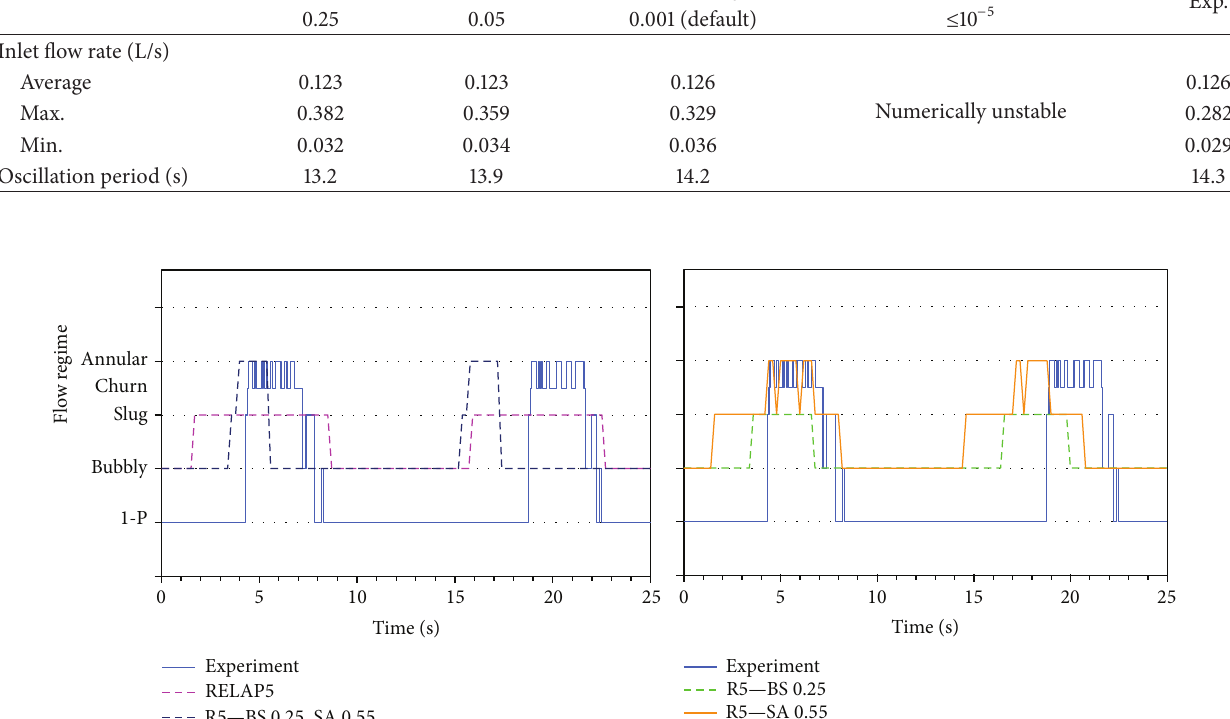
Figure 15: Flow regime in the riser observation section: experimental and RELAP5 data using different flow regime transition boundaries (BS: bubbly-slug; SA: slug-annular).